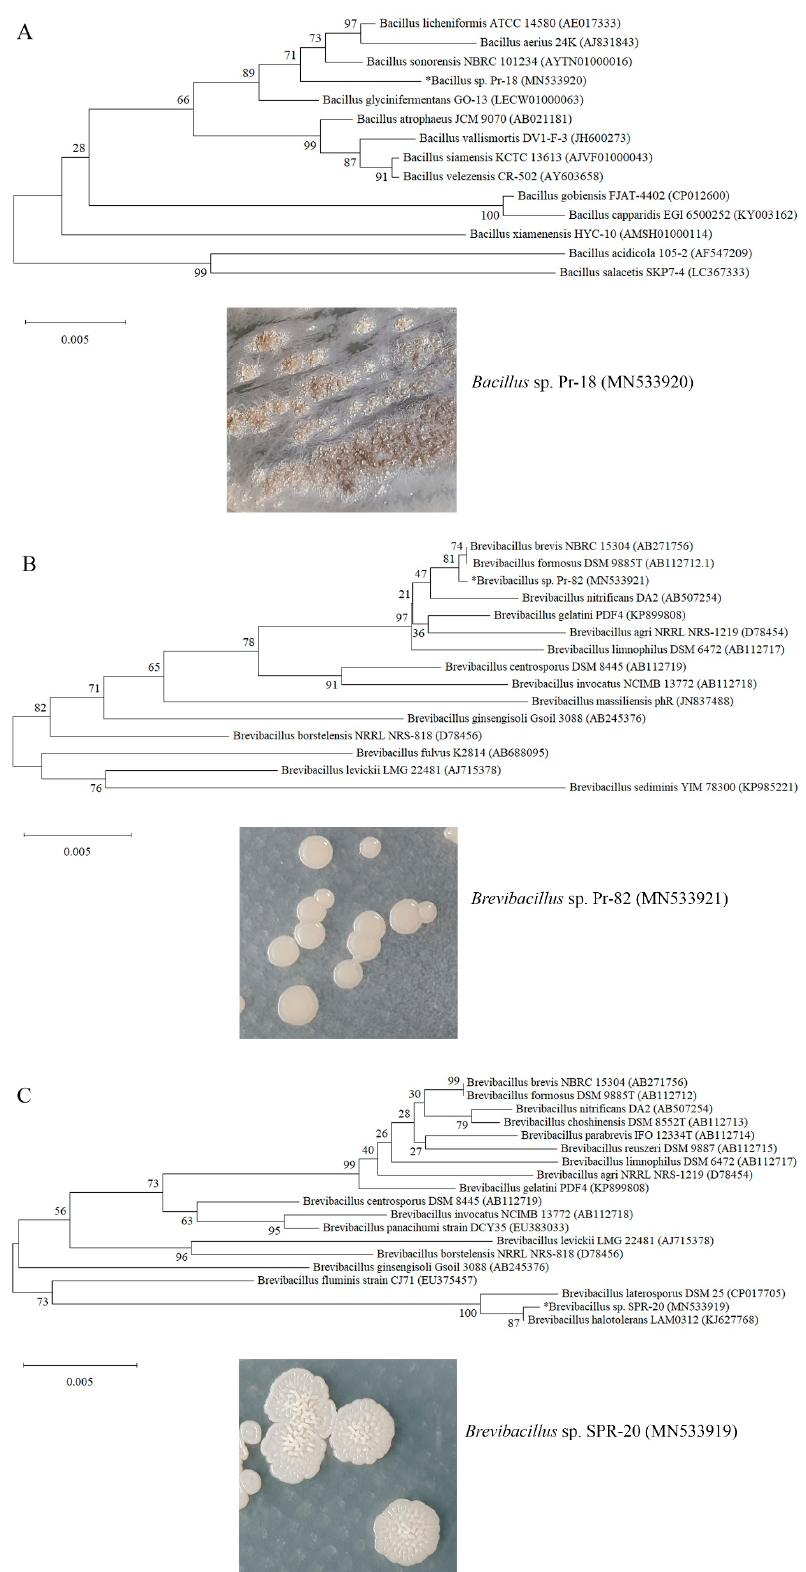
Figure 1. Phylogenetic tree based on 16S rRNA gene sequence and colony morphology of ( A ) Bacillus sp. Pr-18, ( B ) Brevibacillus sp. Pr-82 and ( C ) Brevibacillus sp. SPR-20. The trees were constructed via MEGA X version 10.1.8 using the neighboring-joining method with 1000 bootstrap values. * Indicated the testing isolates.